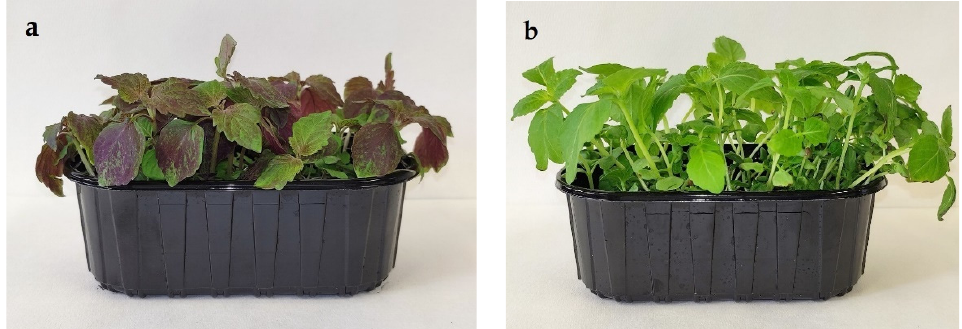
Figure 1. Trays of microgreens of P. frutescens var. crispa ( a ), and var. frutescens ( b ).